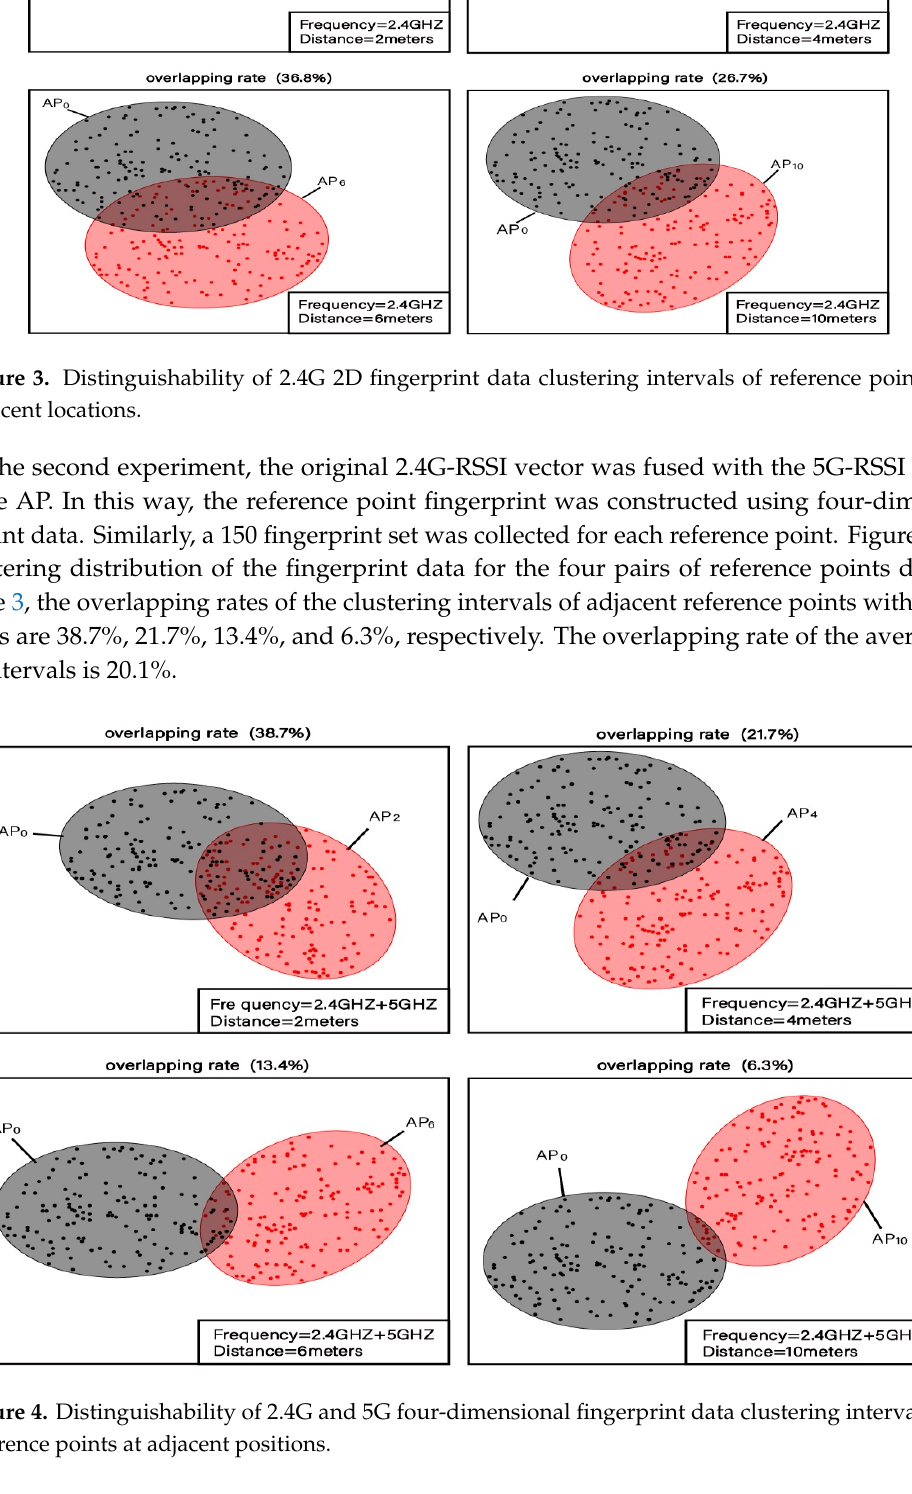
Figure 4. Distinguishability of 2.4G and 5G four-dimensional fingerprint data clustering intervals of reference points at adjacent positions.